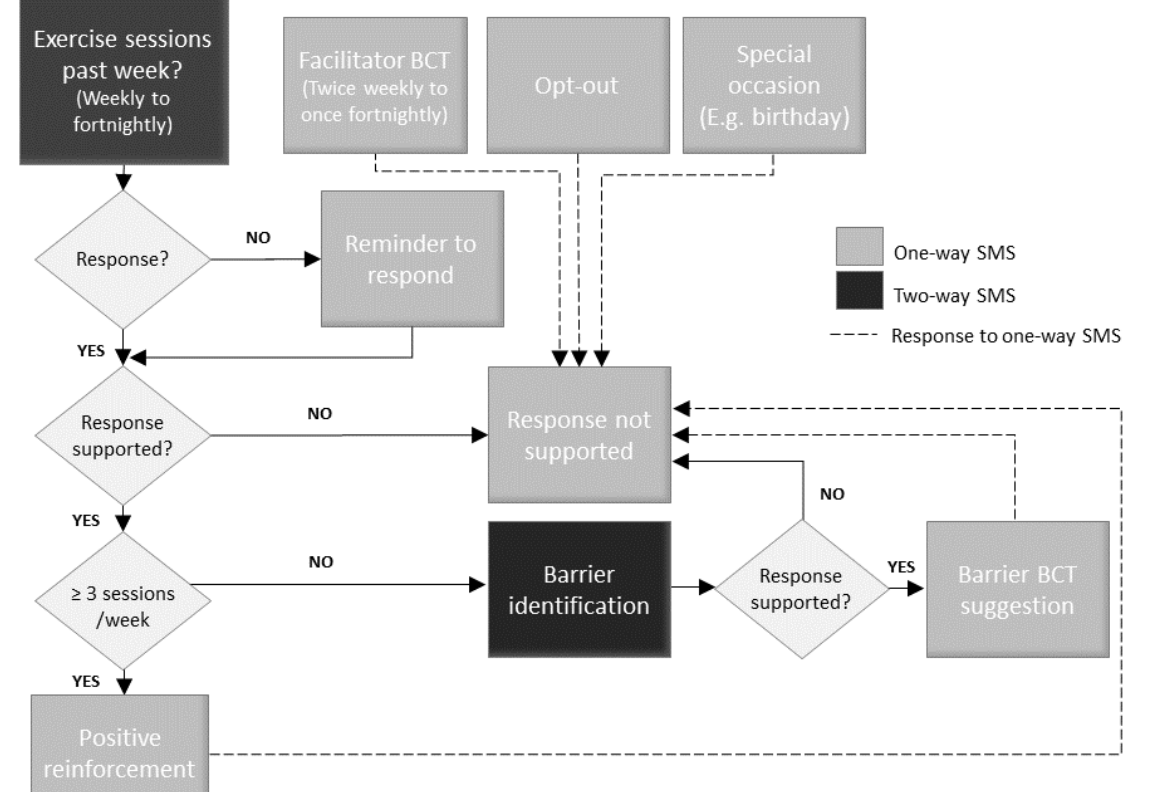
Figure 1. Message interactions and triggers. BCT= behavior change